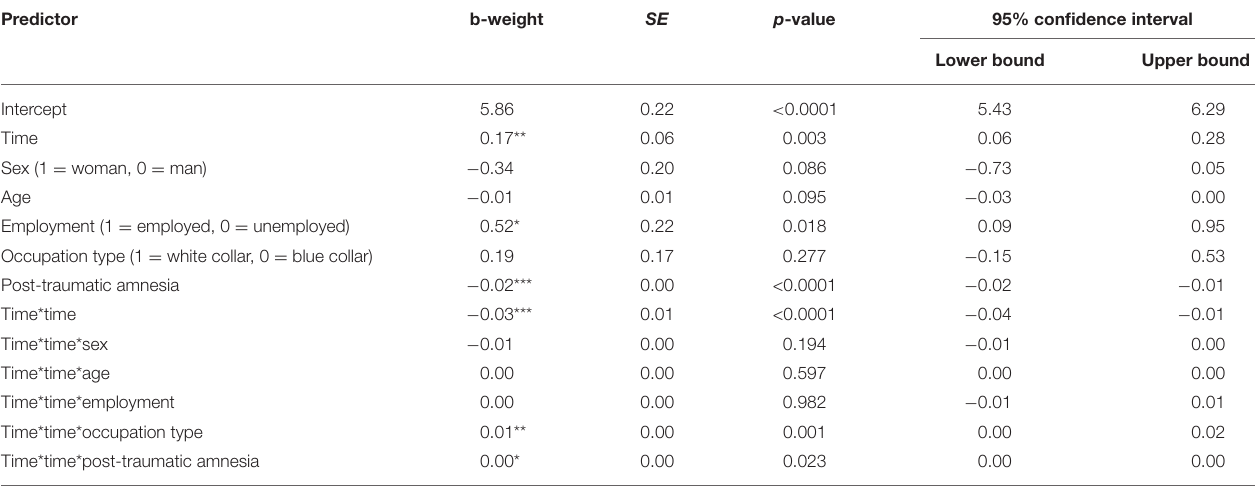
TABLE 5 | Previously significant predictors and quadratic time interactions on GOSE trajectories across 1, 2, 5, and 10 years after injury.